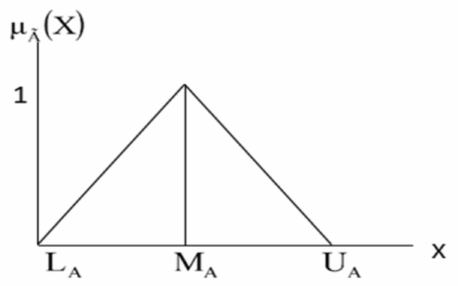
Figure 7. Diagram of a triangular fuzzy number (decision group